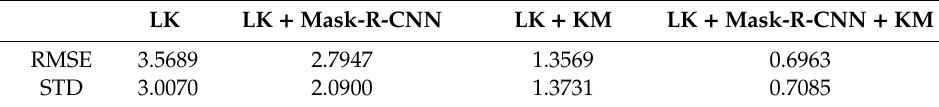
Table 8. Velocity errors of four algorithms in the Y